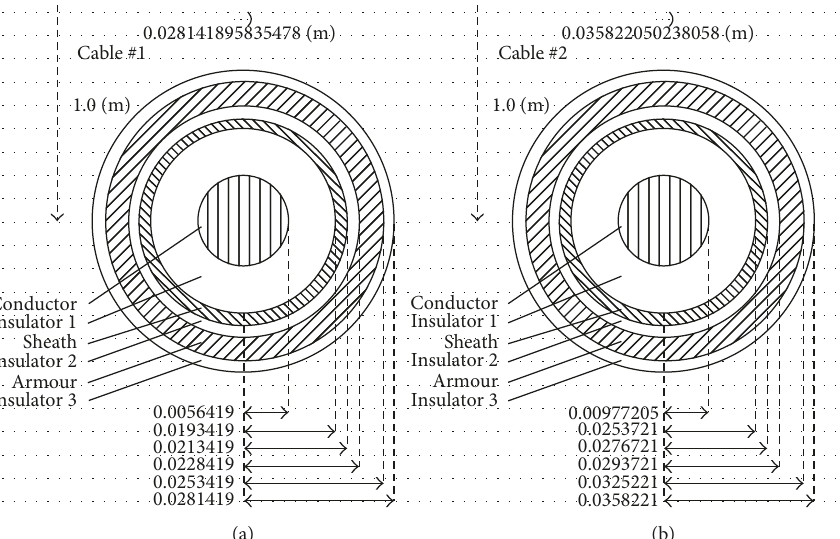
Figure 12: MVDC submarine array cables spacing and dimensions (XLPE, pairs of single core conductor cross section 100mm 2 (a) and 300mm 2 (b))